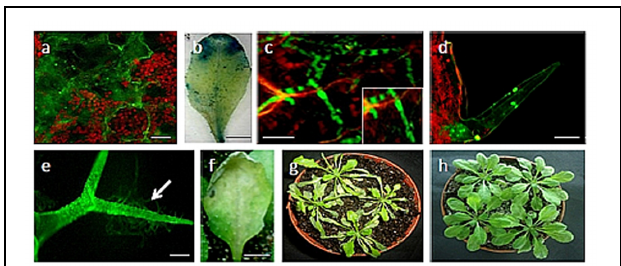
FIGURE 1 | Infection of 4-week-old Arabidopsis thaliana plants (ecotype Columbia) with Ustilaginoidea virens . (a) Germinating conidia on the surface of the leaf; (b) GUS stained Arabidopsis leaf after 72 hpi; (c) a branched mycelium proliferating on the leaf after 72 hpi. The inset shows magnification of the section; (d) and (e) spores and hypha attached on trichomes; (f) formation of chlorotic lesion at the site of inoculation of U. virens isolates after 96 hpi; (g) Infected Arabidopsis plants after 3 dpi; (h) Control Arabidopsis plants. Bars = 100 μ m (a,d,e) , 20 μ m (c) and 50 μ m (b,f) .